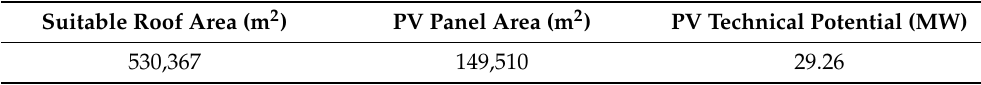
Table 4. Lampedusa PV technical potential on roofs.